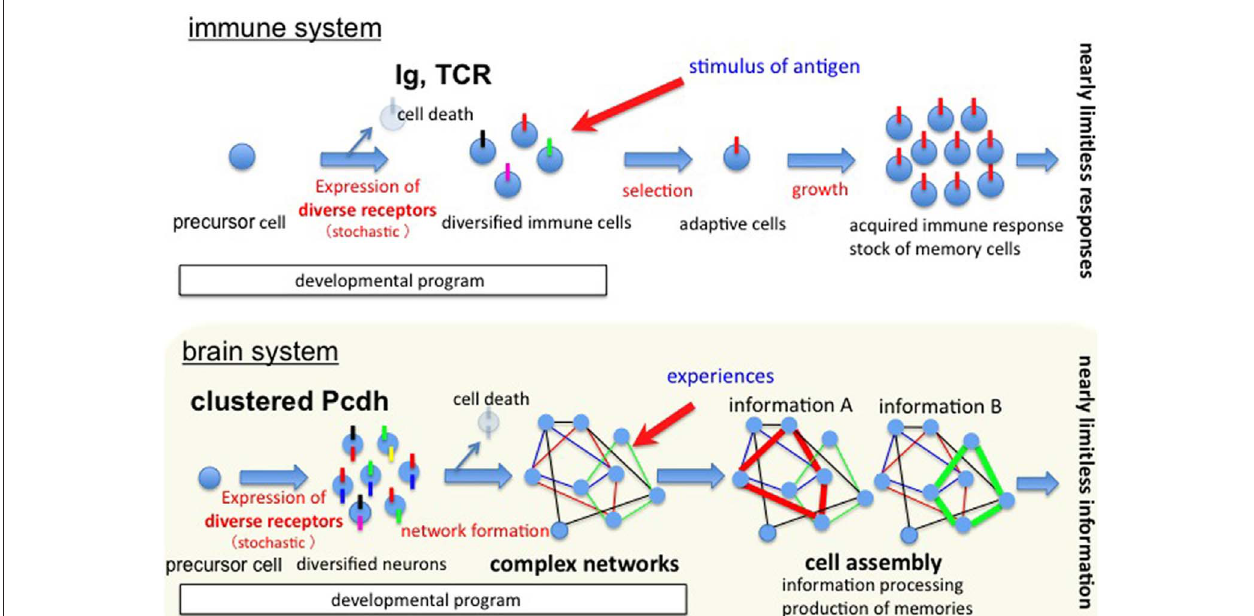
FIGURE 7 | Diagrams of memory systems for both the immune system and the brain. (A) In the immune system, an enormous number of diverse immune cells are developmentally produced; thus a set of pre-functional immune cells prepared early in life. The mechanism for diversity is the stochastic DNA rearrangement of the immunoglobulin ( Ig ) and T-cell receptor ( TCR ) genes. After infection with external antigens, the appropriate immune cells for responding to the antigen are selected, expanded, and stored in memory in the form of memory cells. In this way, numerous and nearly limitless adaptive immune responses and antigen memories are generated. Thus, the functional immune cells are predetermined by developmental programming, including a stochastic mechanism. (B) In the brain system, clustered Pcdh isoforms from the α , β , and γ gene clusters are stochastically expressed in neurons to produce individual neuronal identities. The expressed clustered Pcdh isoforms produce functional cis -tetramers. At the